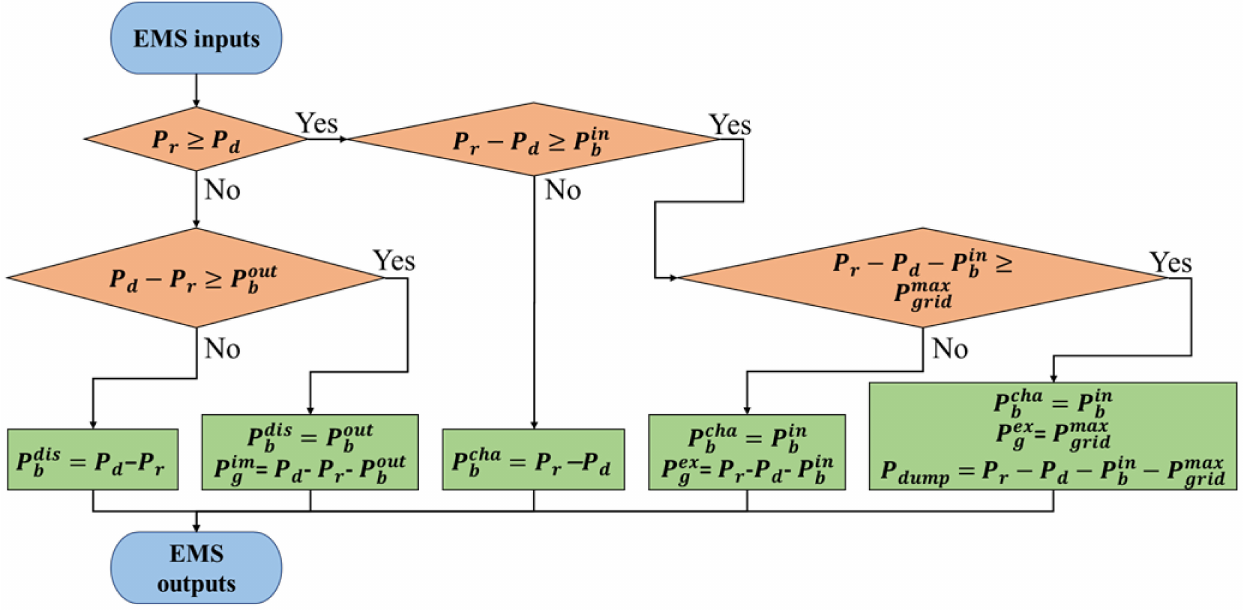
Figure 2. Rule-based flow chart of EMS under Flat-Flat rates.